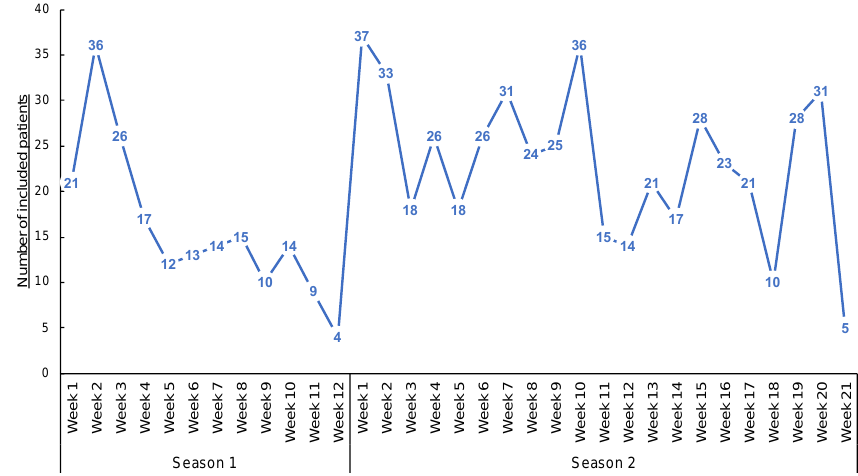
Figure 4. Number of inclusions during the weeks of inclusions. Table 1. Characteristics of the patients.